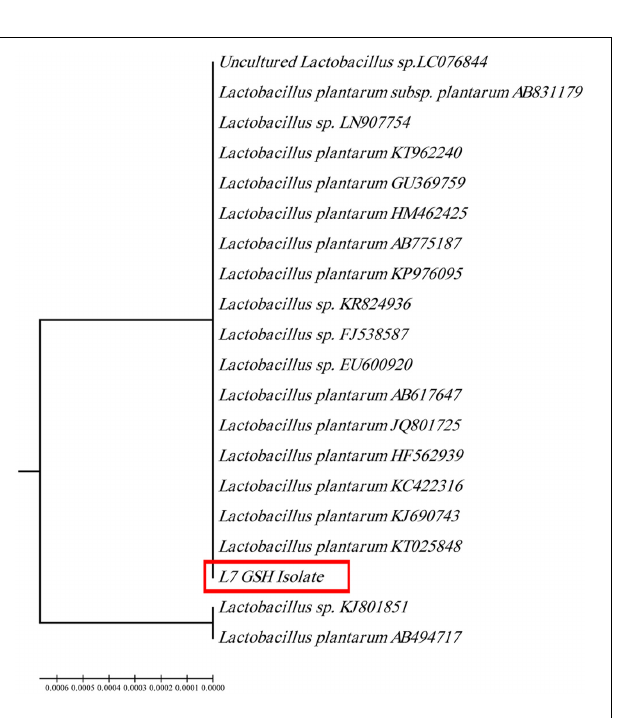
FIGURE 2 | Phylogenetic tree of the isolate coded (L 7 GSH) showing the position of this isolate among the selected Lactobacilli based on 16Sr RNA sequences from NCBI.